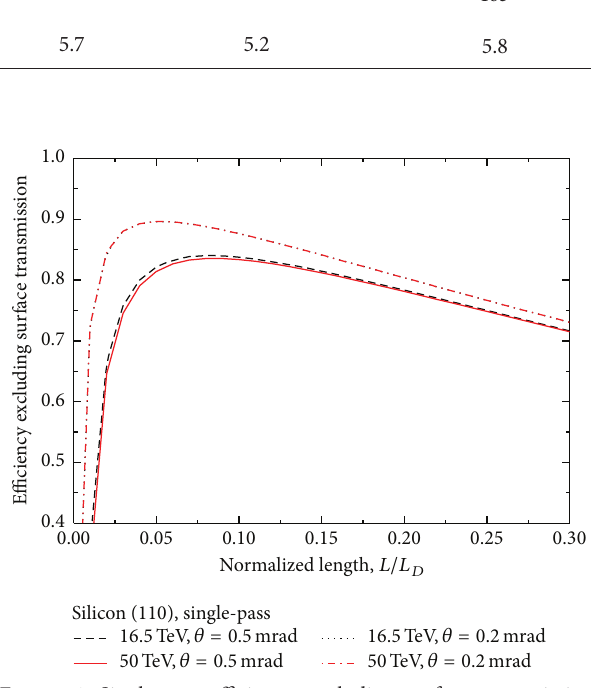
Figure 1: Single-pass efficiency, excluding surface transmission, calculated as in [6]. The angles and energies are given in the